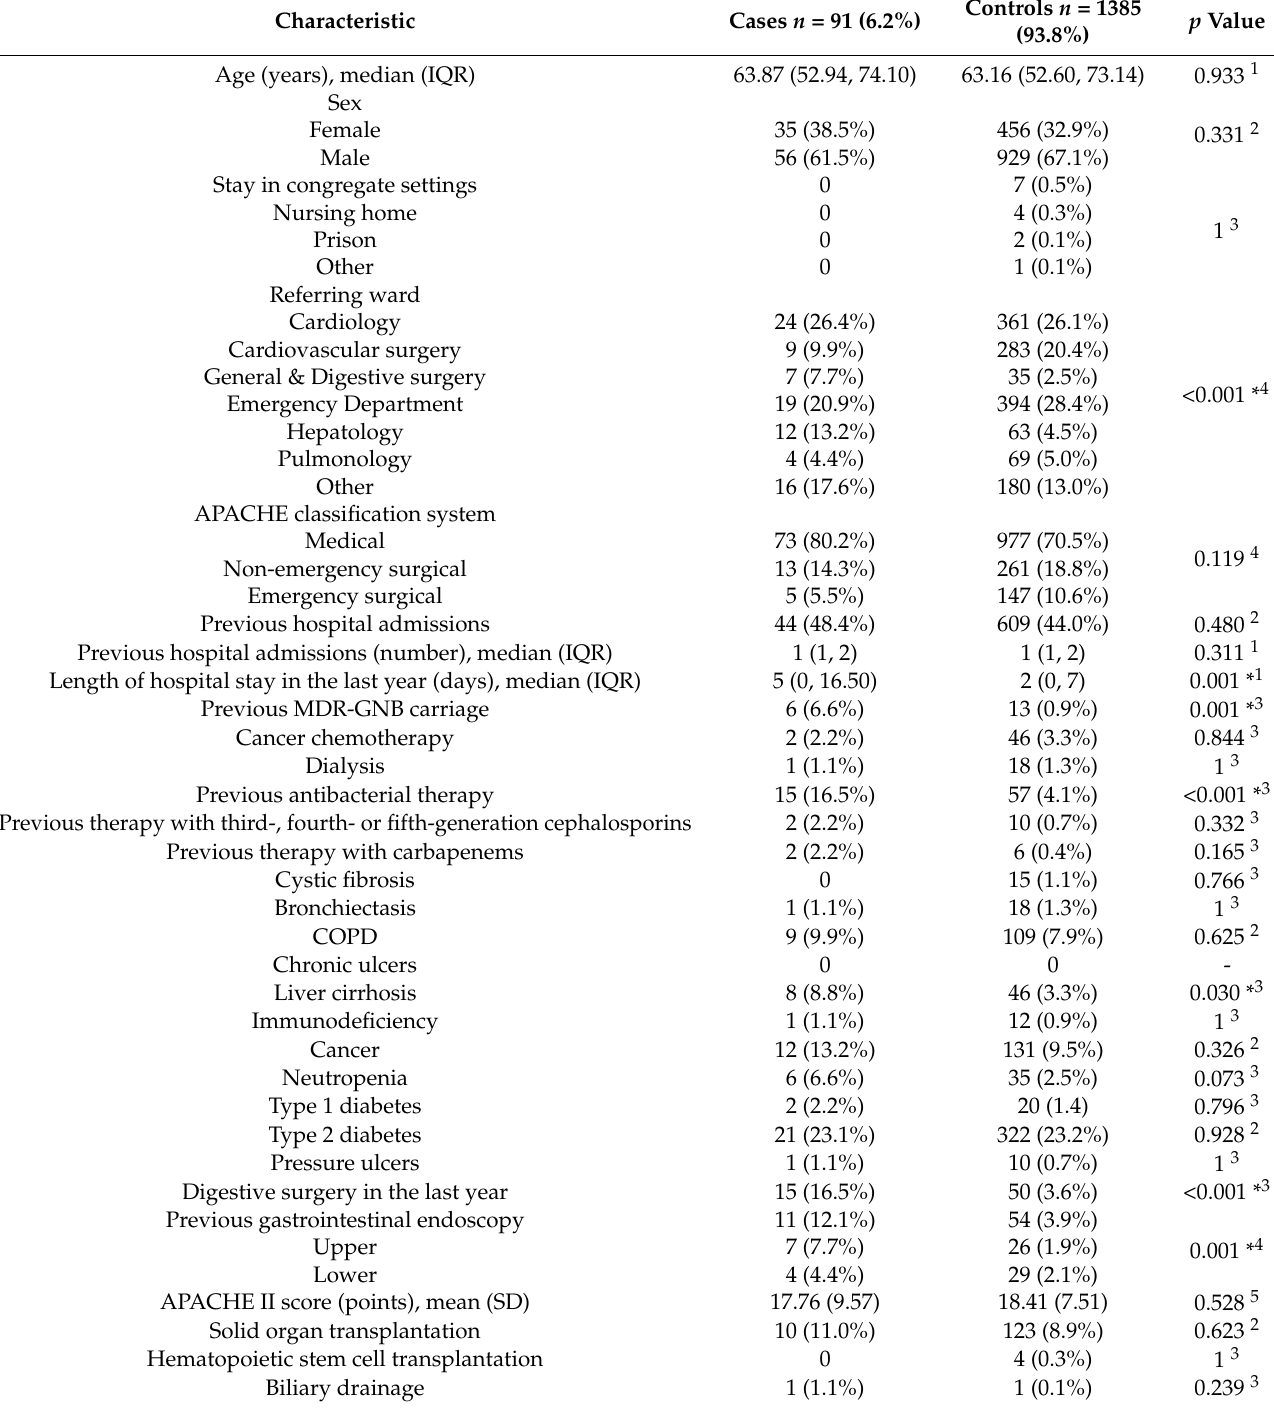
Table 1. Baseline characteristics of cases and controls upon ICU